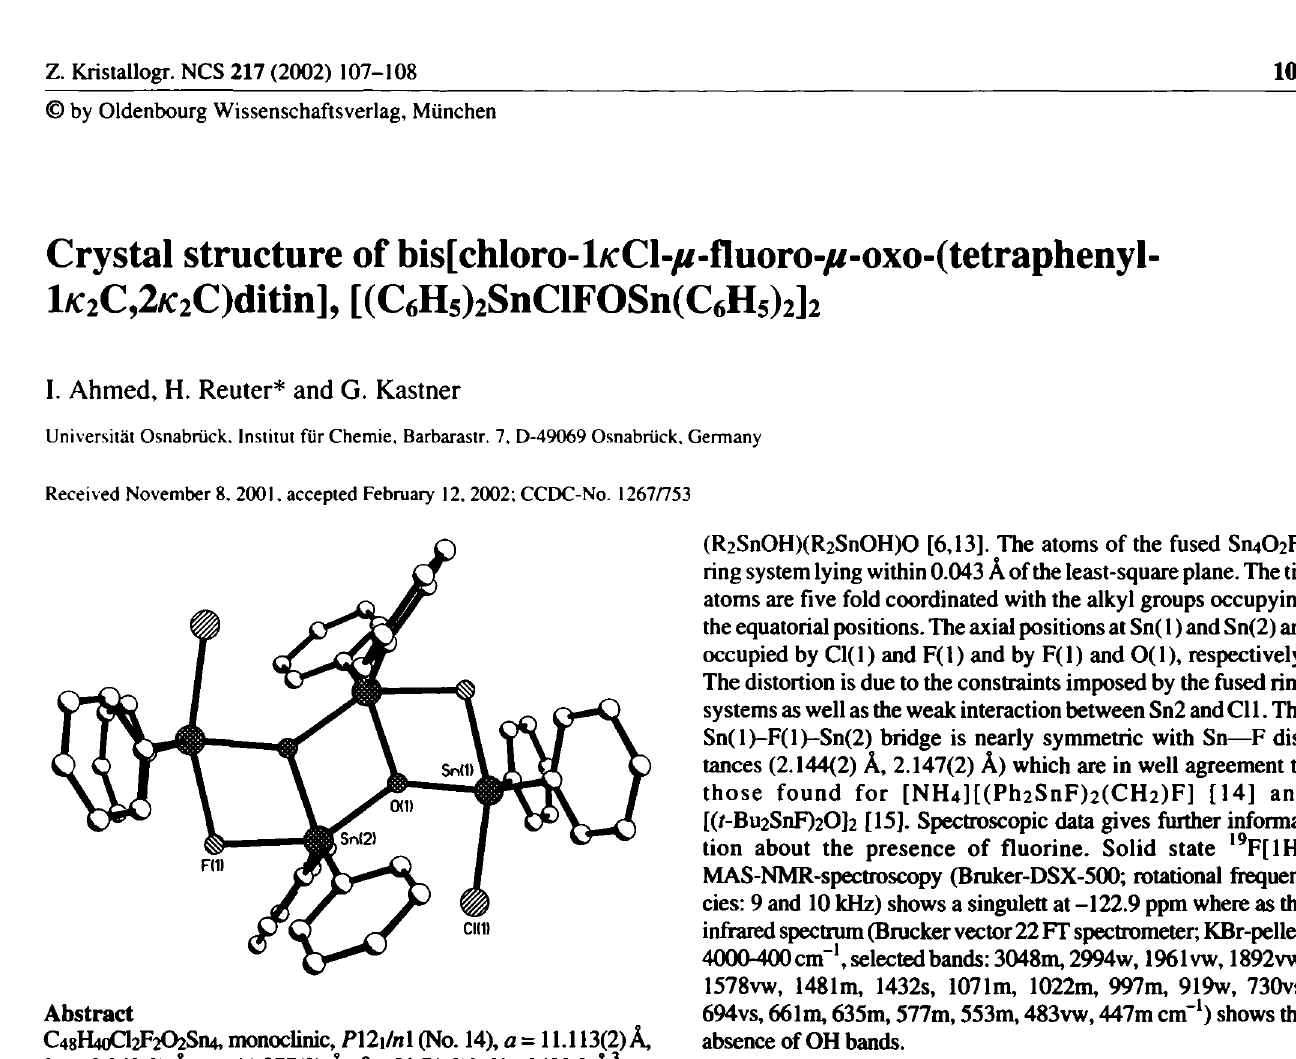
Table 1. Data collection and handling.